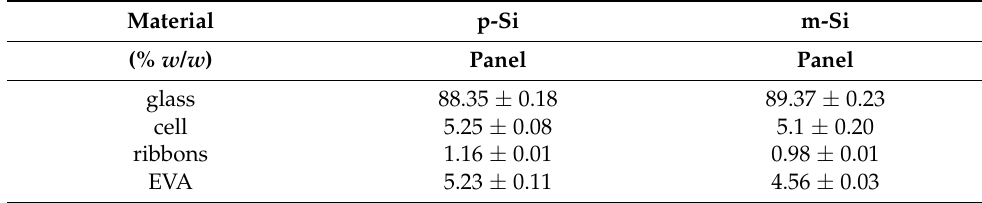
Table 3. Gravimetric determination of panel